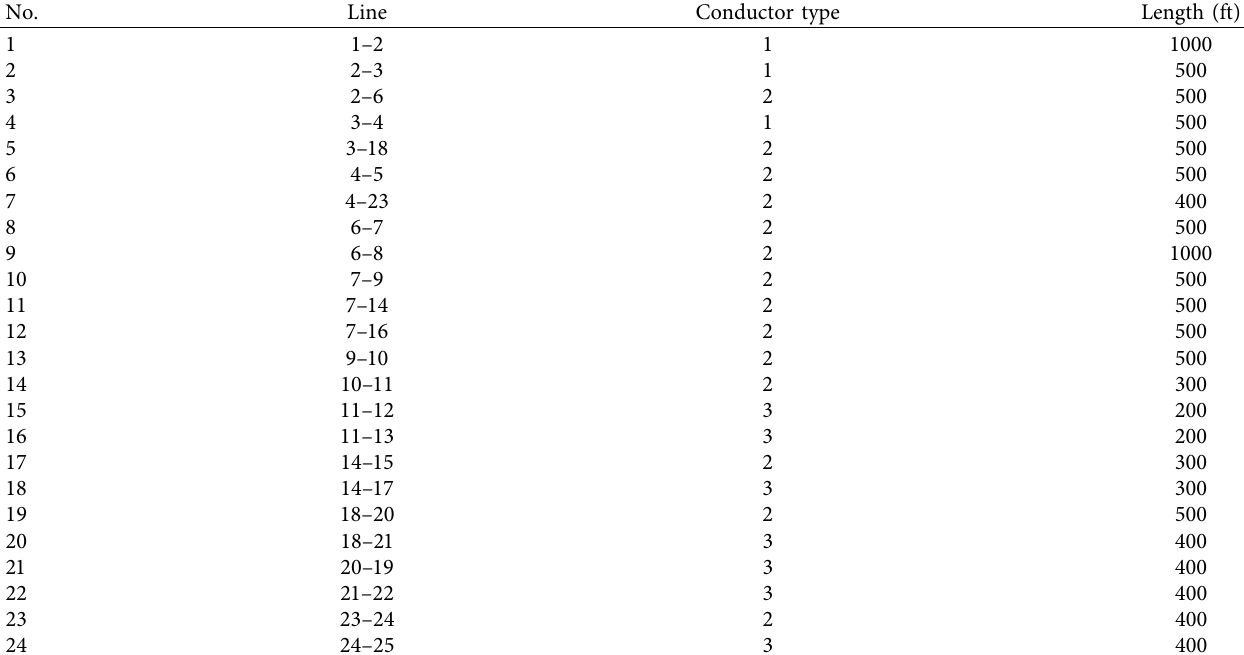
Table 5: Type and length of conductor lines of 25-bus network.